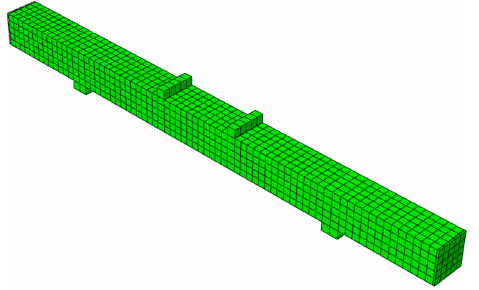
Figure 8. Finite element model of the specimen.